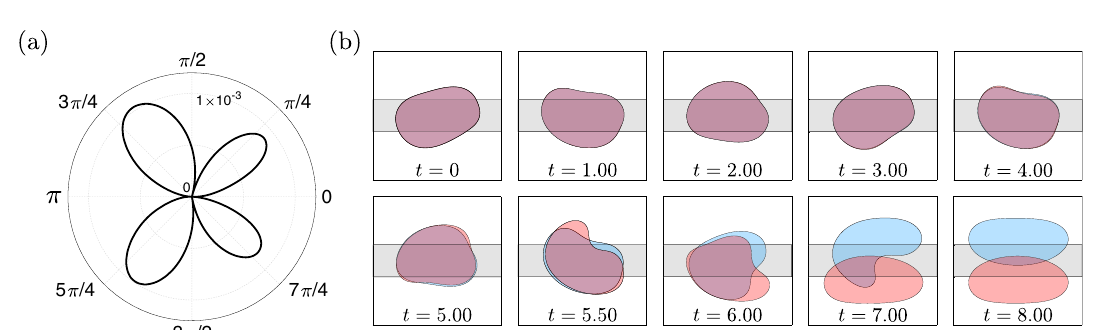
Figure 5. Time-evolutions of the bubble centroid lateral offset y following a series of marginally-different initial perturbations applied to bubbles of size r = 0.54 at dimensionless flow rate Q = 0.032 in the depth-averaged model. The projection of the UPO in this space is represented by the black dashed curve. Bottom inset: bubble shapes at the final time-step, where the colour of each bubble corresponds to the same colour curve. Top inset: zoom-in on the initial values of y and after the first two time-steps.